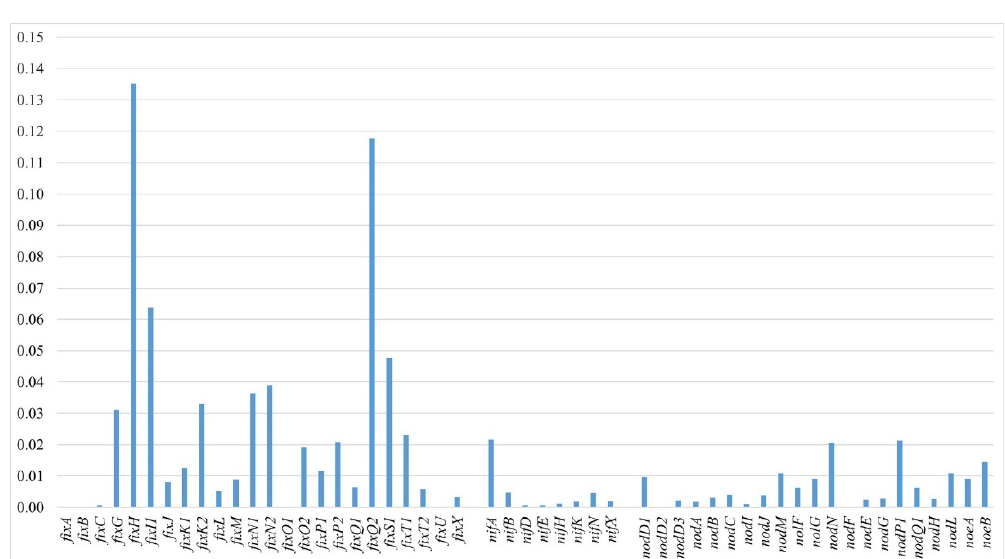
Figure 6. p -distance values for sym genes of E. meliloti L6-AK89 compared with Rm1021.